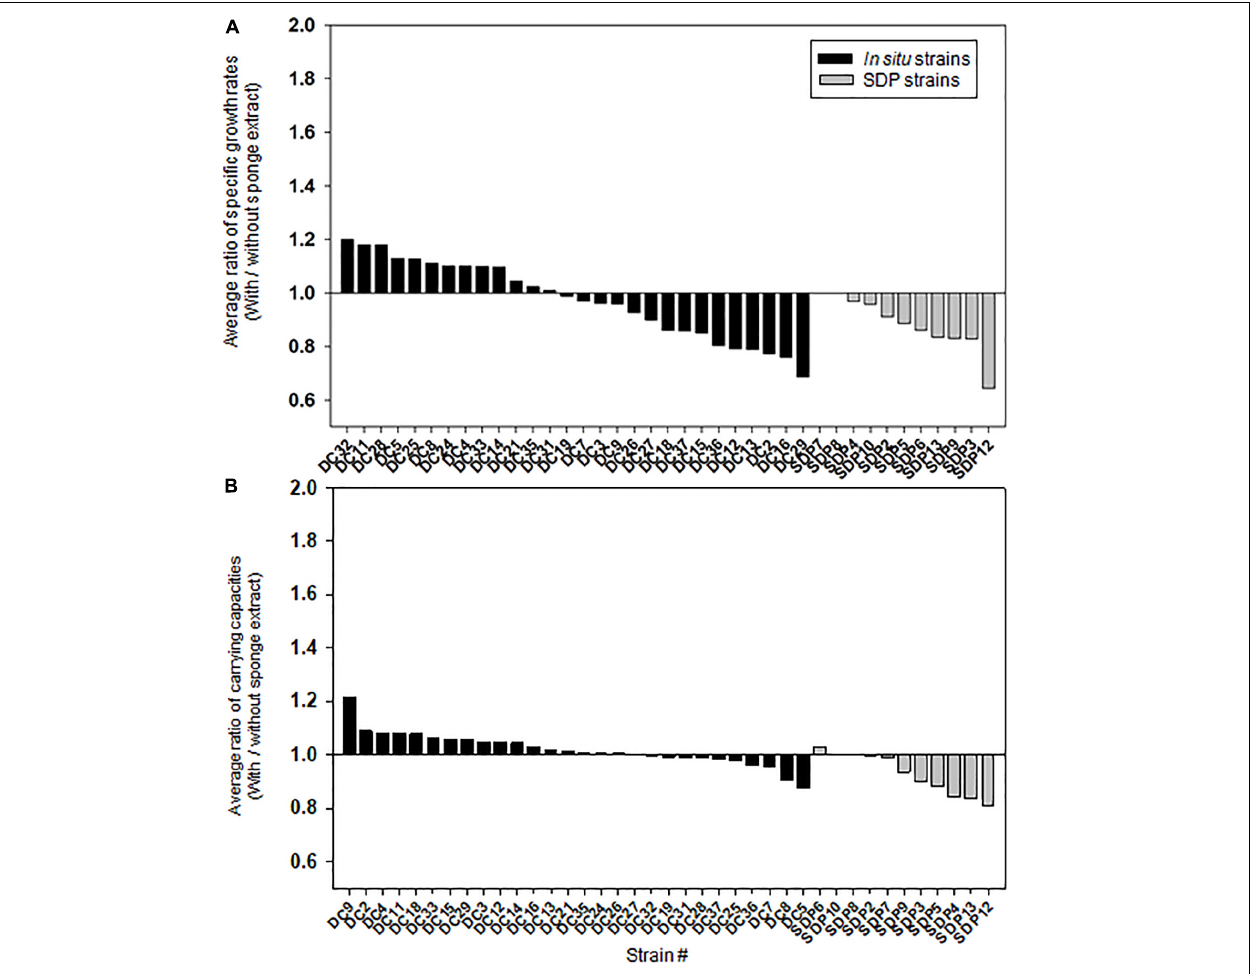
FIGURE 5 | Effect of the sponge extract on specific growth rate (A) and saturated cell density (B) of the in situ and SDP strains. The ratio of the specific growth rate ( µ ) between the value measured under the two culture conditions ( µ with the sponge extract/ µ without the sponge extract) was calculated for each tested strain (A) . The ratio of the saturated cell density (maximum value of OD 600 ) between the value measured under the two culture conditions (saturated cell density with the sponge extract/saturated cell density without the sponge extract) was calculated for each tested strain (B) . The ratio of specific growth rate and saturated cell density was calculated with average value from triplicate experiments ( n =